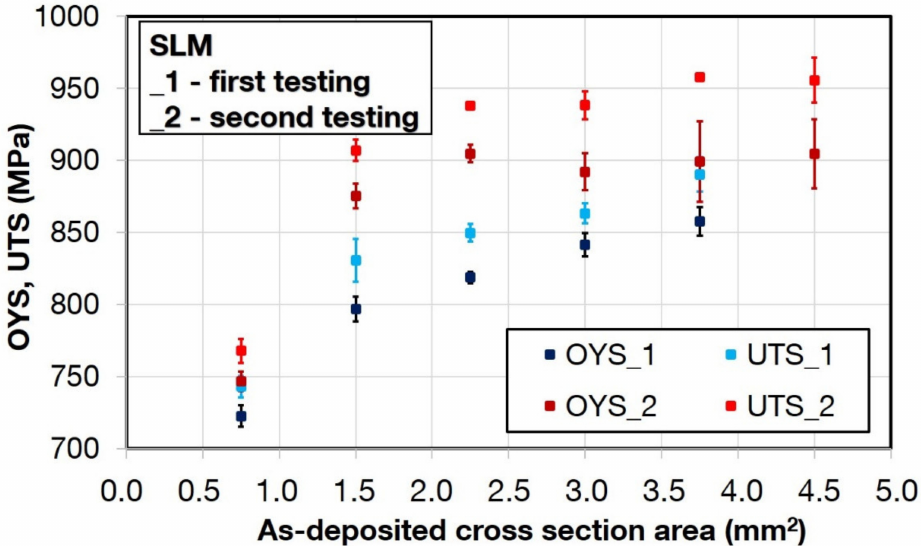
Figure 15. Average strength values obtained from the first (“1”) and the second (“2”) batch of testing SLM-processed samples.